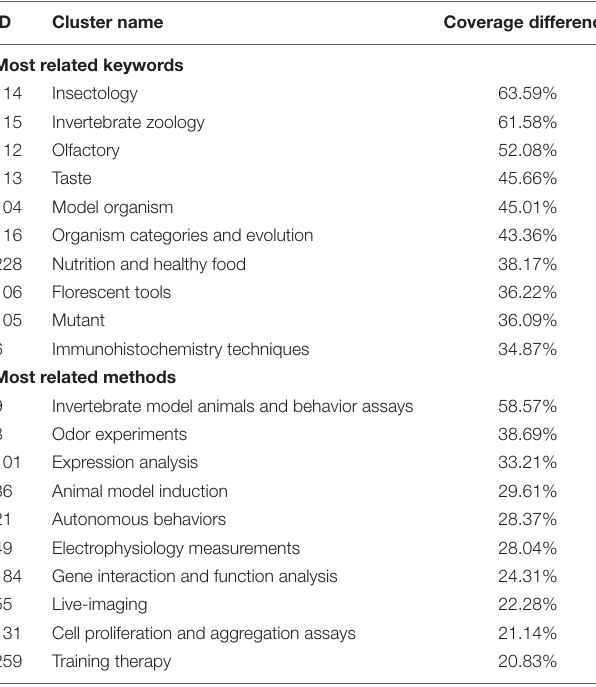
TABLE 2 | Coverage of keywords and methods in all articles related to learning and memory.